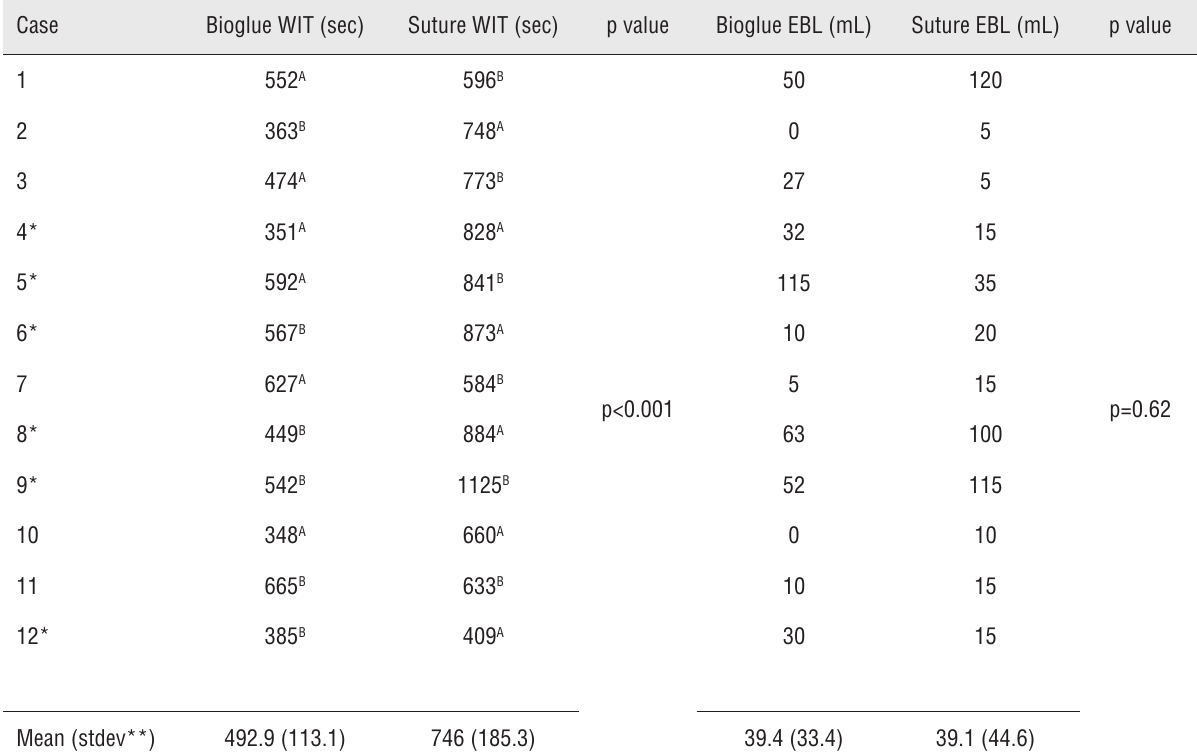
Table 1 - Warm ischemia time (WIT) and estimated blood loss (EBL) for the use of bioglue and suture.